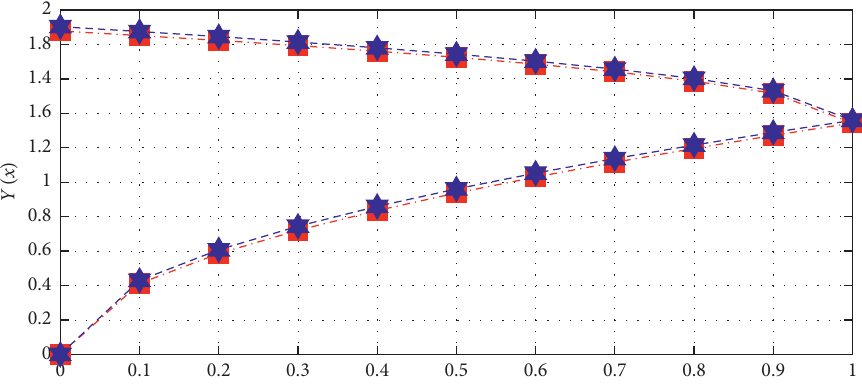
Figure 6: The exact and computed solution for Example 2. Red chart indicates real data, and blue chart indicated approximate data.